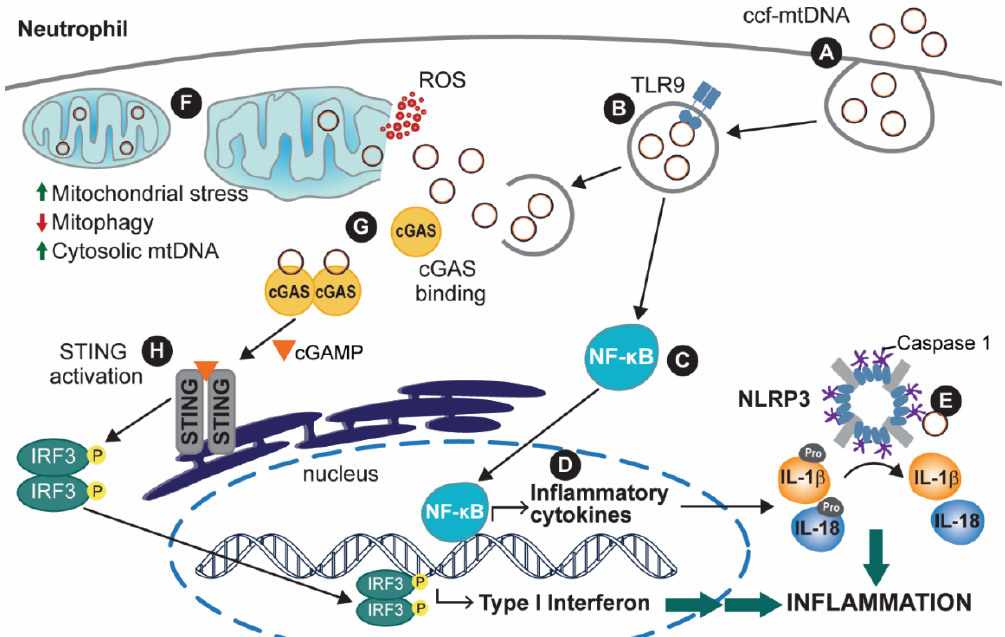
Figure 2. The inflammatory response after mtDNA release from mitochondria or ccf-mtDNA internalization. ( A ) Internalization of ccf-mtDNA leads to ( B ) activation of Toll-like receptor 9 (TLR9) and ( C ) upregulation of nuclear factor-κB (NF-κB), which ( D ) promotes the expression of inflammatory cytokines. Additionally, a rise in intracellular reactive oxygen species (ROS) causes ( E ) NOD-, LRR-, and pyrin domain-containing protein 3 (NLRP3) activation, ultimately leading to NLRP3 inflammasome assembly. This causes caspase-1 (CAS1)-mediated pro-interleukin (pro-IL) activation, leading to either localized inflammation or cytokine release. Alternatively, ( F ) mtDNA can be released to the cytosol and bind cyclic GMP-AMP synthase (cGAS) following endosomal rupture, or ( G ) mtDNA release from mitochondria. mtDNA release from the mitochondria can be a result of mitochondrial dysfunction or impaired mitophagy. ( H ) cGAS-bound mtDNA can lead to a type I interferon (IFN) response, which further contributes to the inflammatory response from ( E ). While mtDNA is depicted in an intact and circular form, mtDNA fragments in linear or circular form may also elicit similar immune responses.